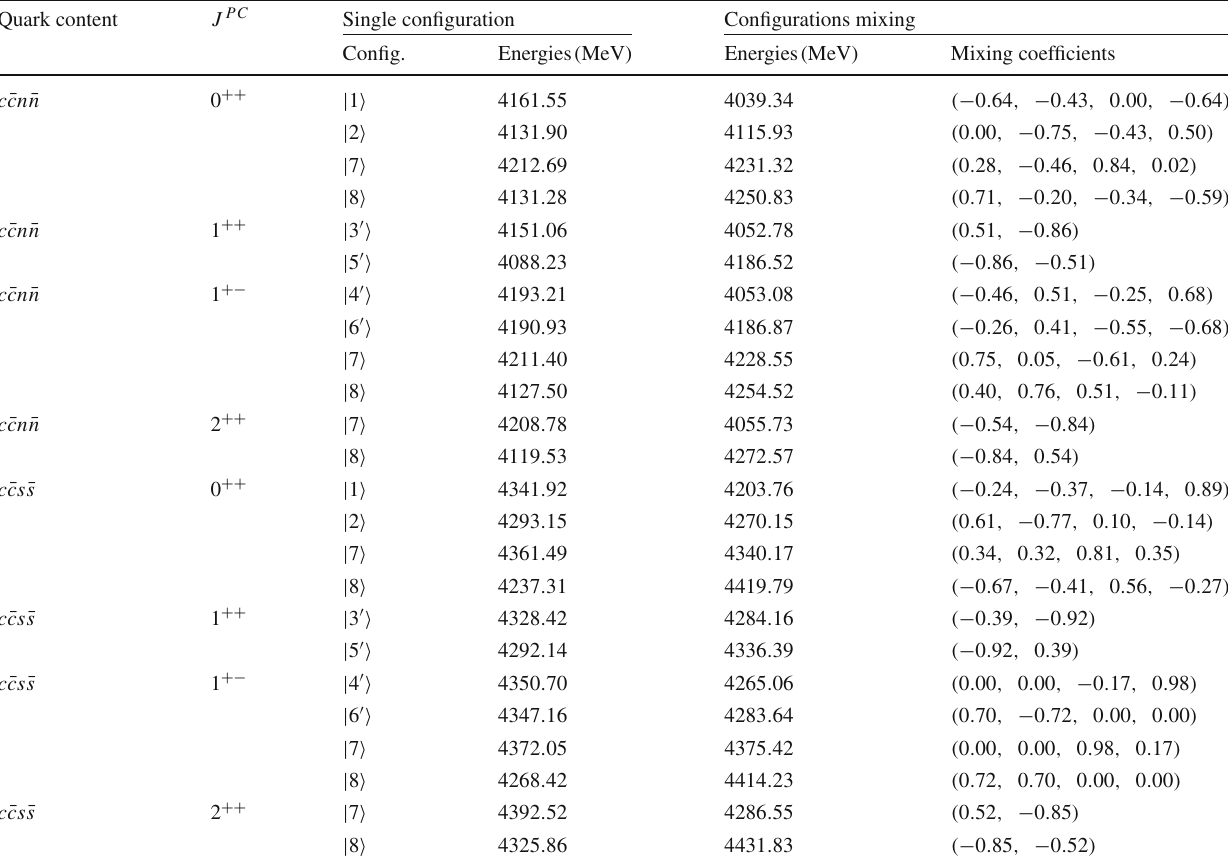
Table 7 The numerical results of ground S -wave X states with I G = 0 +